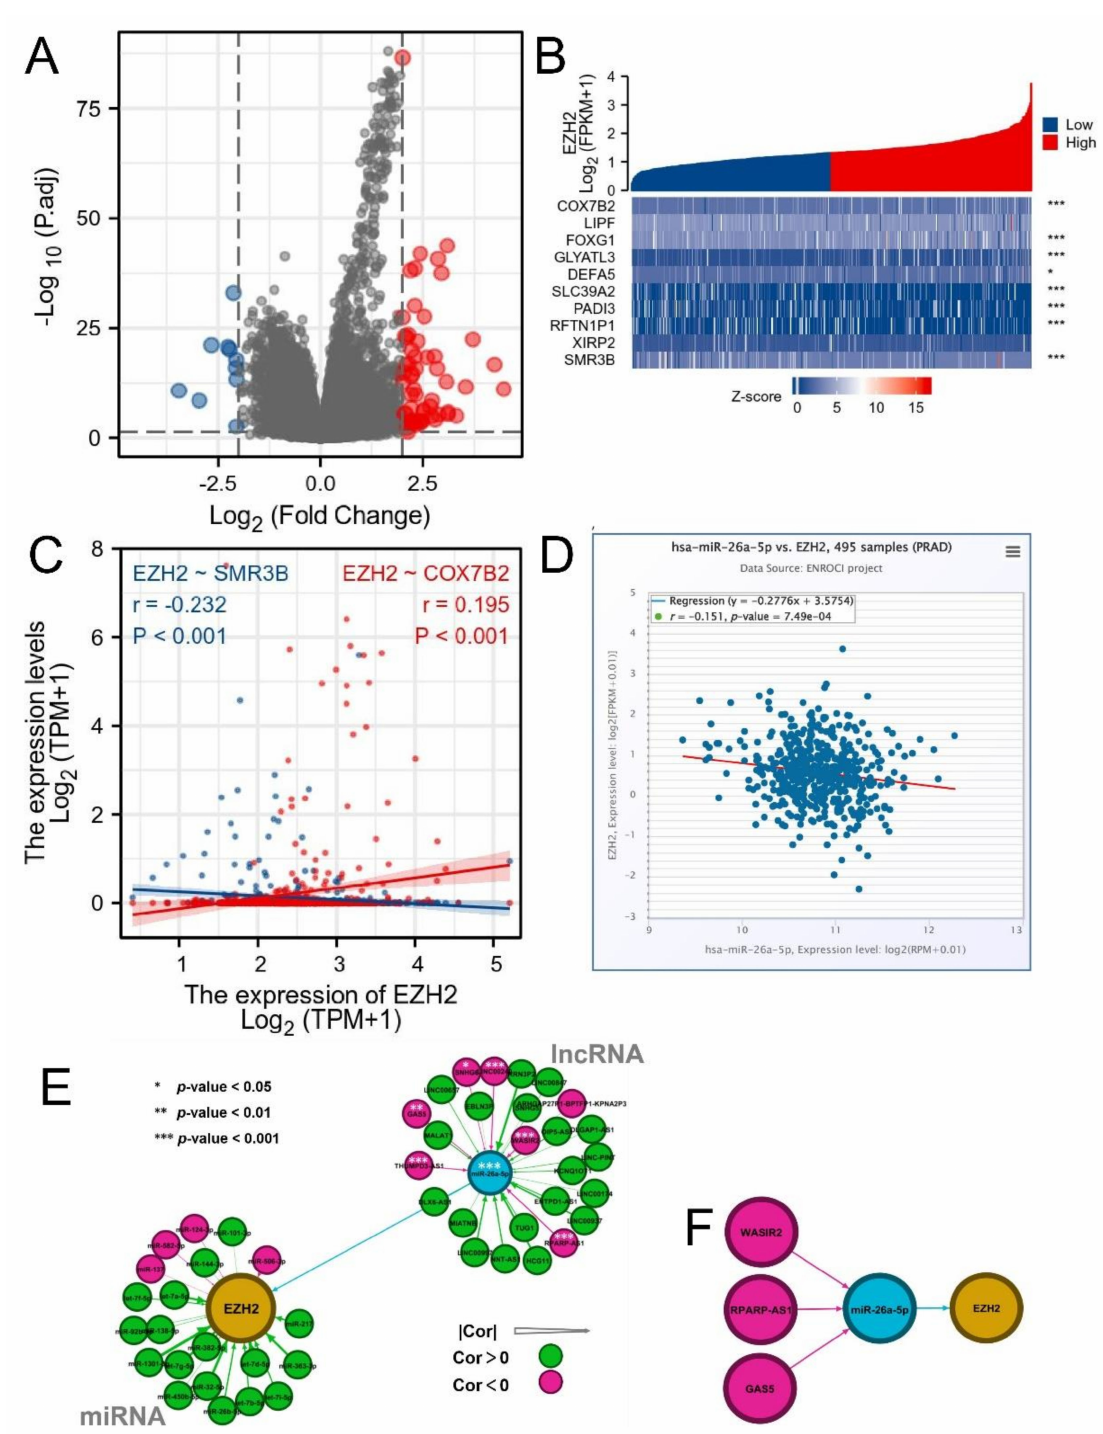
Figure 7. DEGs and prediction of upstream miRNAs and lncRNAs of EZH2: ( A ) Volcano map of DEGs; ( B ) Correlation heat map of the top 5 up- and down-regulated genes with EZH2; ( C ) Correlations of EZH2 with COX7B2 and SMR3B expression in PRAD; ( D ) Correlations of EZH2 with miR-26a-5p in PRAD; ( E ) Network indicates potential upstream miRNAs and lncRNAs that may modulate EZH2; ( F ) The GAS5, THUMPD3-AS1, and WASIR2/miR-26a-5p/EZH2 axis. No significance, p -values < 0.05, 0.01, and 0.001 were presented as “ns”, “*”, “**”, and “***”,